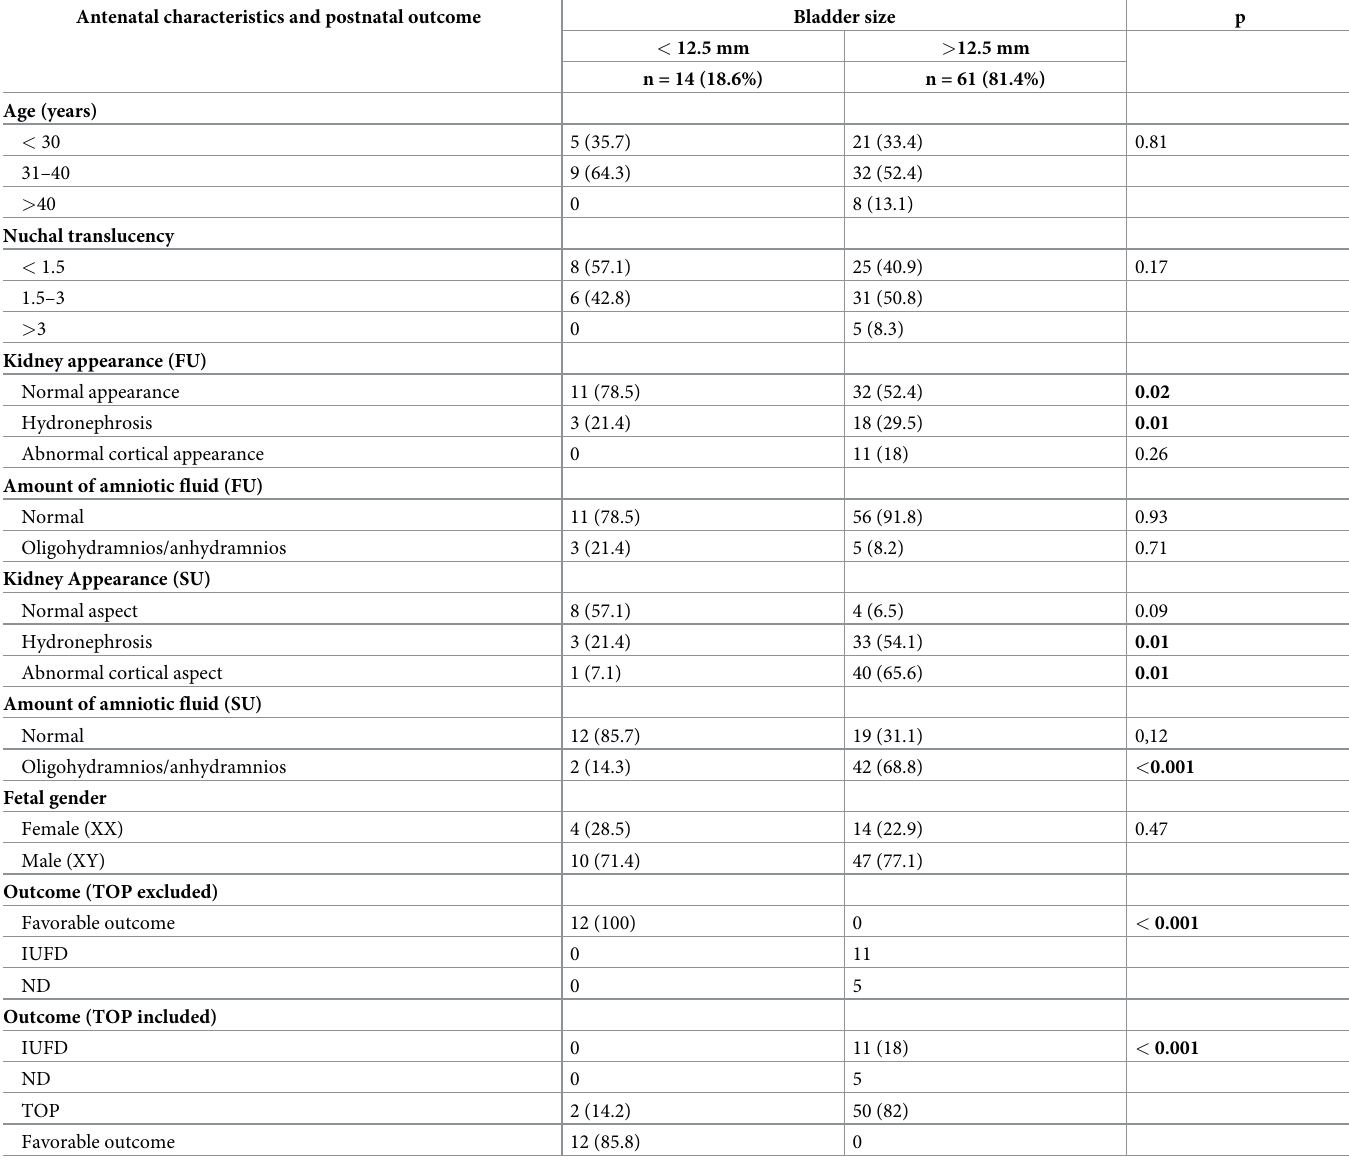
Table 2. Univariate analysis: Analysis of US antenatal characteristics and neonatal outcomes according to bladder size. Antenatal characteristics and postnatal